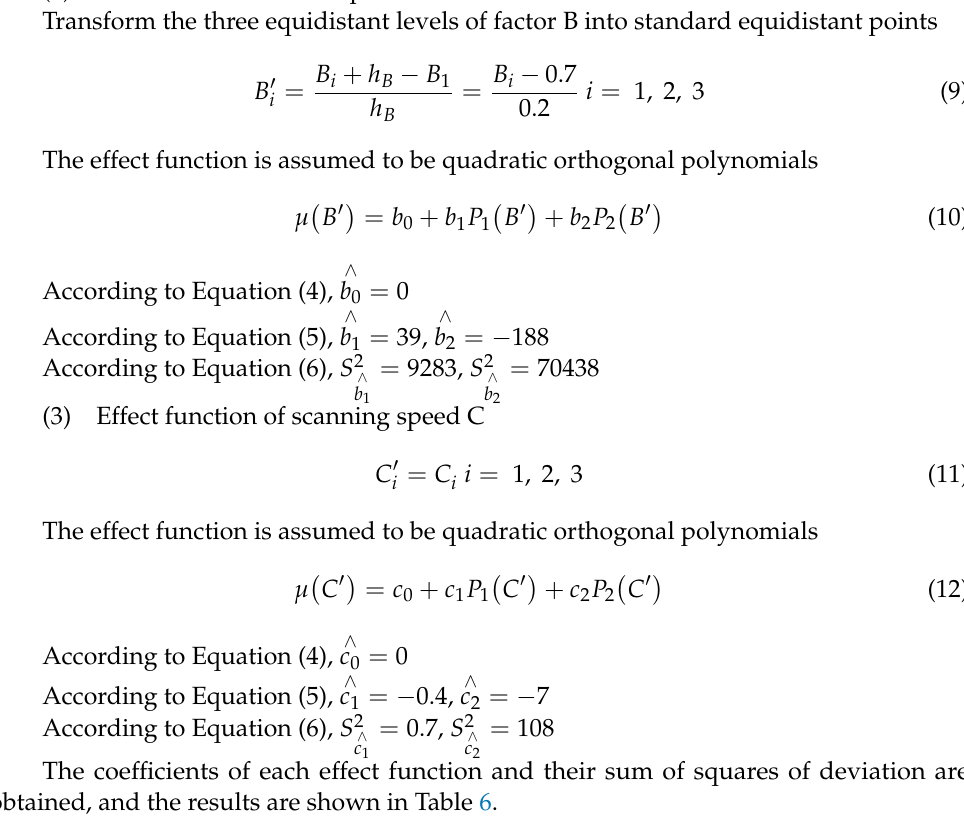
Table 6. The coefficient of the effect function and the sum of its dispersion squared. Feeding Voltage